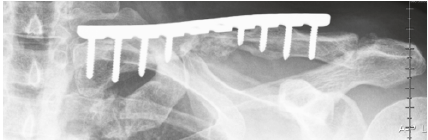
Figure 1: Before surgery.